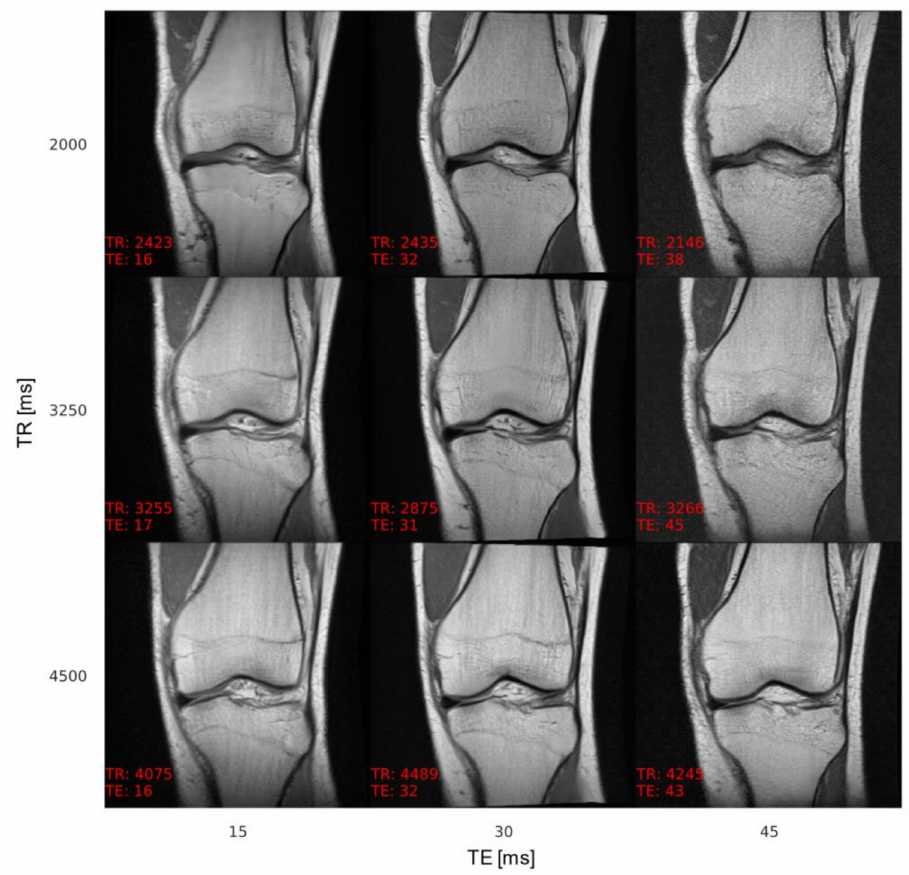
Figure 3. Acquisition parameter interpolation of TR and TE for a single latent vector. A single latent vector was reconstructed with different TR and TE values, showing the capability of the generator to synthesize MR images with adaptable image contrast. The axes describe the intended acquisition parameter values and the values at the bottom left of each image the output of the AC. The images are annotated (in red) with acquisition parameter values as determined by the AC, showing a low overall conditioning error. The contrast adapts properly within images along the axes; however, the anatomy also slightly changes, which is a sign of feature entanglement of the latent vector with the